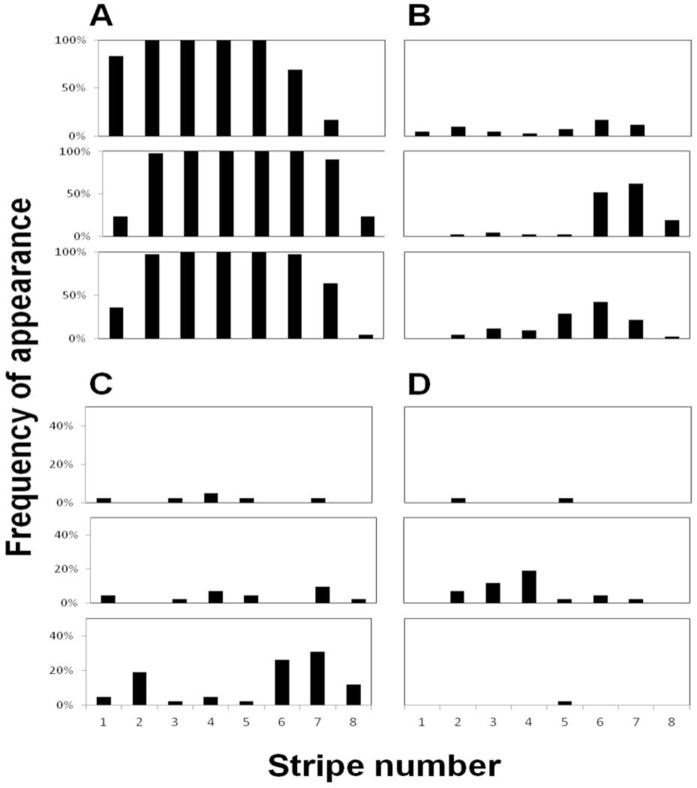
Feature location and frequency of appearance in the body pattern of the C. paucifasciatus from head to tail (stripe numbers 1–8, respectively; n  =  42 patterns).(A) Black vertical stripes, (B) crossings, (C) holes, and (D) splits. Note that the scale in (C) and (D) goes up to 50% only. In each subset, dorsal, middle, and ventral sections are represented by the three panels from top to bottom, respectively. Note the 100% appearance of stripes three through five in all three sections (A).